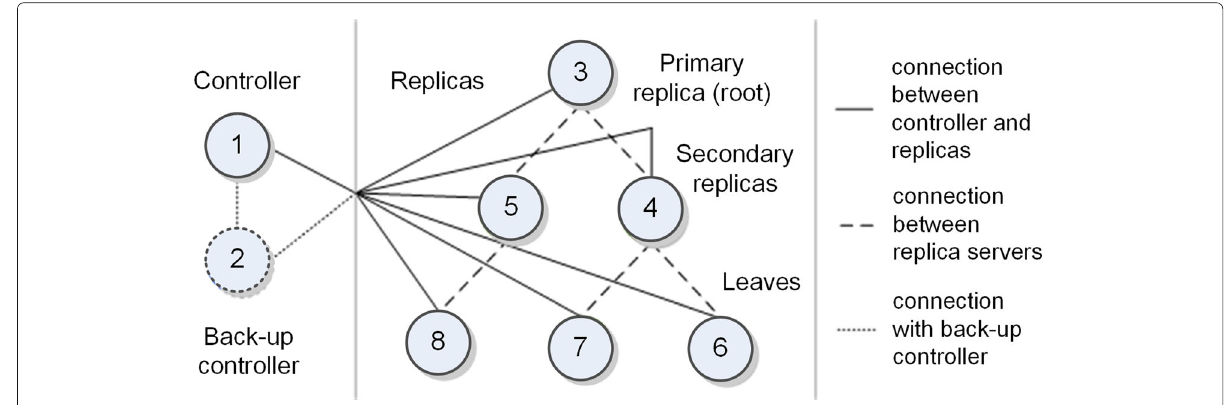
Fig. 10 Communication connections of different components within the R-TBC tree structure